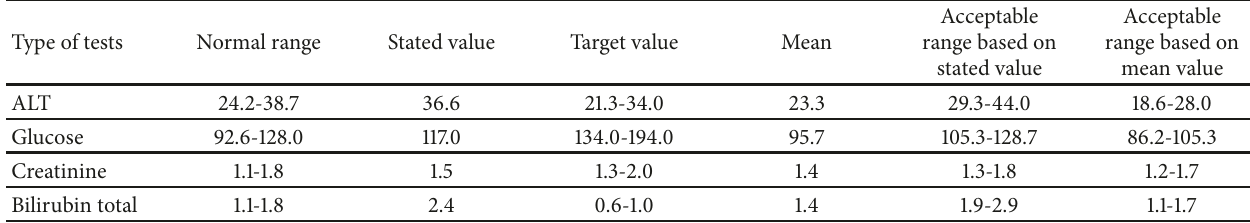
Table 4: Normal range, stated value, target value (manufacturer), mean of participating laboratories, and acceptable values based on TEa ± 20%, ± 10%, ± 15%, and ± 20 for each analytes ALT, glucose, creatinine,and total bilirubin, respectively, from Humatrol N control sample given in IU/L and